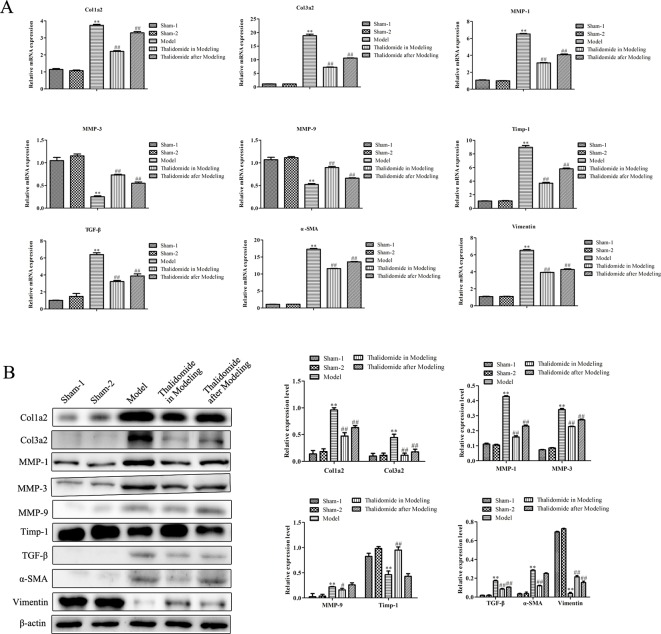
Effects of thalidomide on mRNA and protein expression related to fibrosis in mice induced with TNBS. (A) QRT-PCR assay was performed to evaluate the expression levels of fibrosis-related mRNA in mice from different groups. (B) Western blot assay was performed to evaluate the expression levels of fibrosis-related proteins in mice from different groups. **P < 0.01 compared with the sham-1 and sham-2 groups; #
P < 0.05, ##
P < 0.01 compared with the model group.